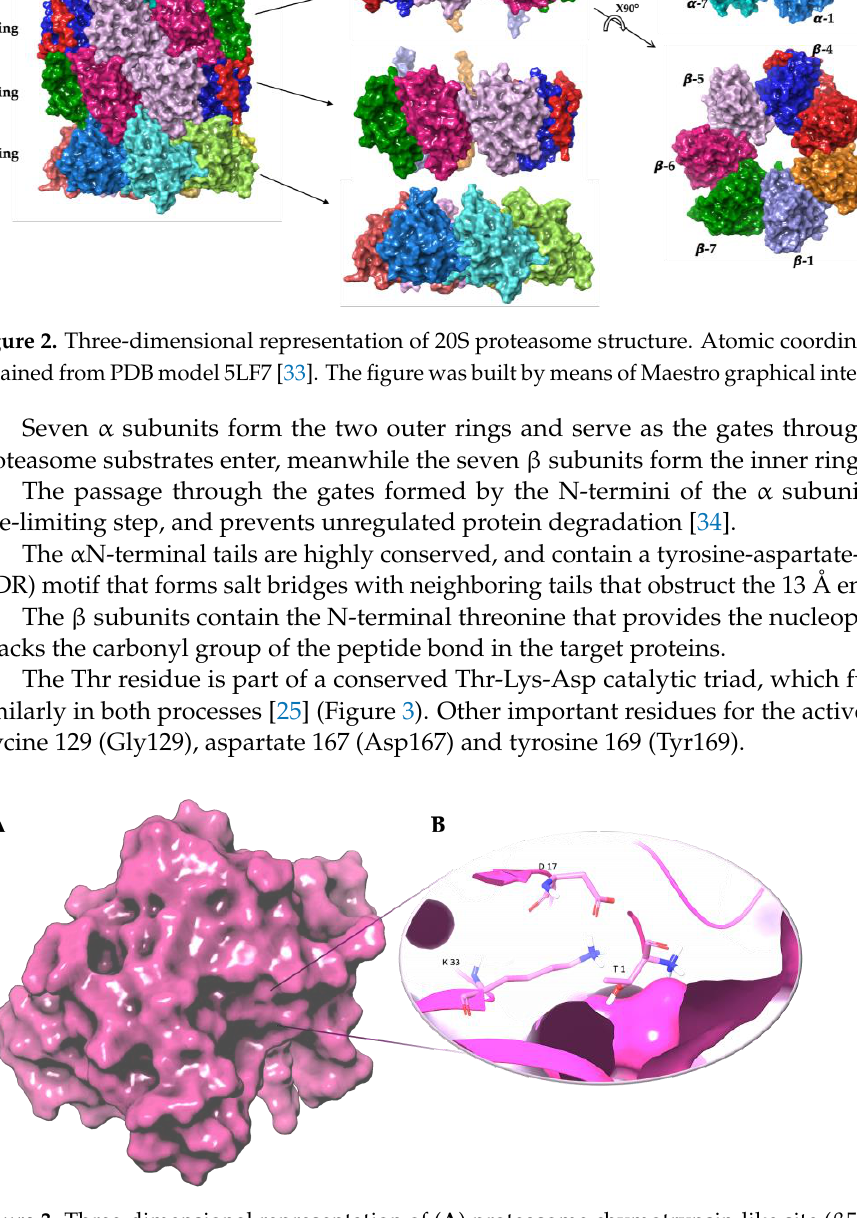
Figure 3. Three-dimensional representation of ( A ) proteasome chymotrypsin-like site ( β 5); ( B ) Thr- Lys-Asp catalytic triad of the chymotrypsin-like site ( β 5). The β 5 subunit is represented as magenta surface and the conserved residues are shown as magenta carbon sticks. Atomic coordinates were obtained from PDB model 5LF7 [33]; the figure was built by means of Maestro graphical interface [30]. The Thr1, Asp17 and Lys33 are the most important residues for the proteolytic mecha- nism meanwhile the other residues are important for the active site integrity